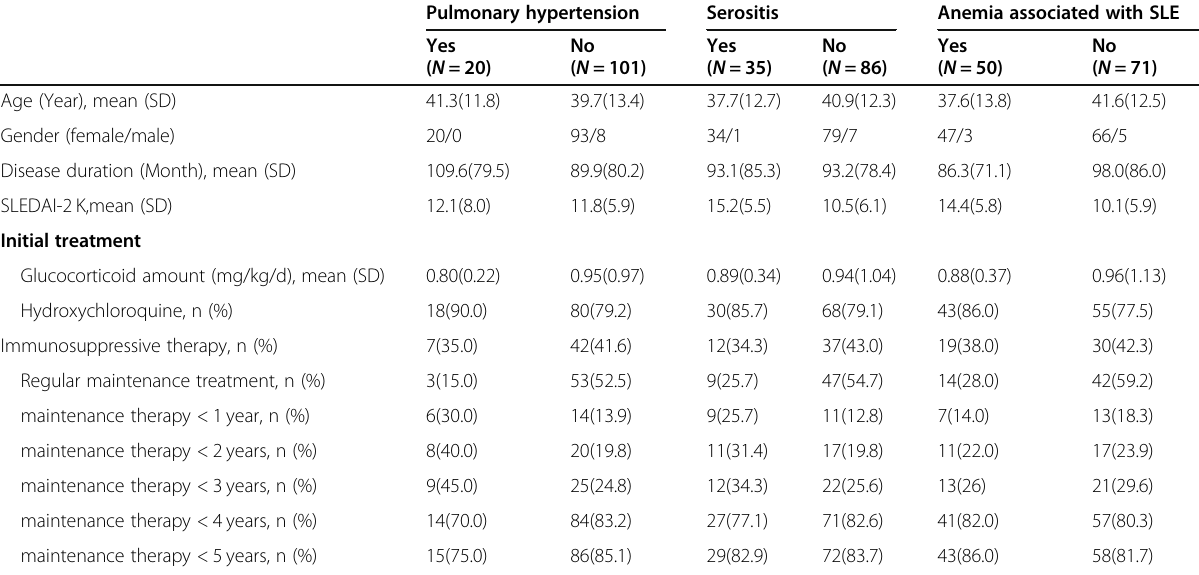
Table 6 Distribution of patients with SLE flare Pulmonary hypertension Serositis Anemia associated with SLE